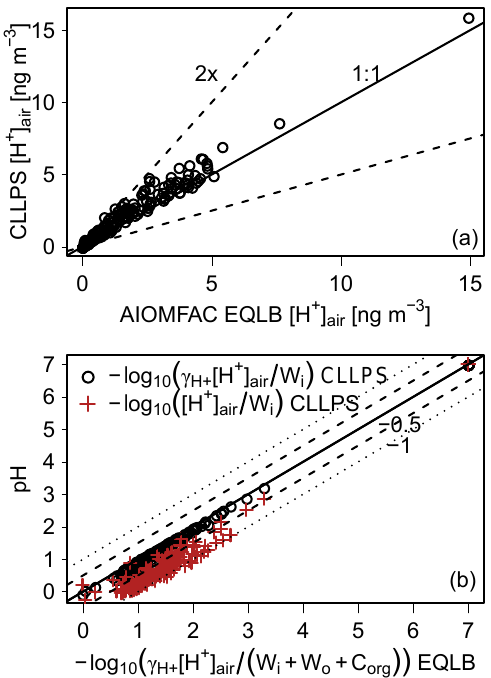
Figure 4. (a) [H + ] air and (b) pH predicted for PM 2 . 5 using AIOM- FAC. Dashed lines in (a) indicate a factor of 2 difference from the 1 : 1 line. Dashed lines in (b) represent a ± 0 . 5 shift in pH while dotted lines represent a ± 1 shift in pH. Series marked in open circles ( ◦ ) are summarized in Table 1. All calculations